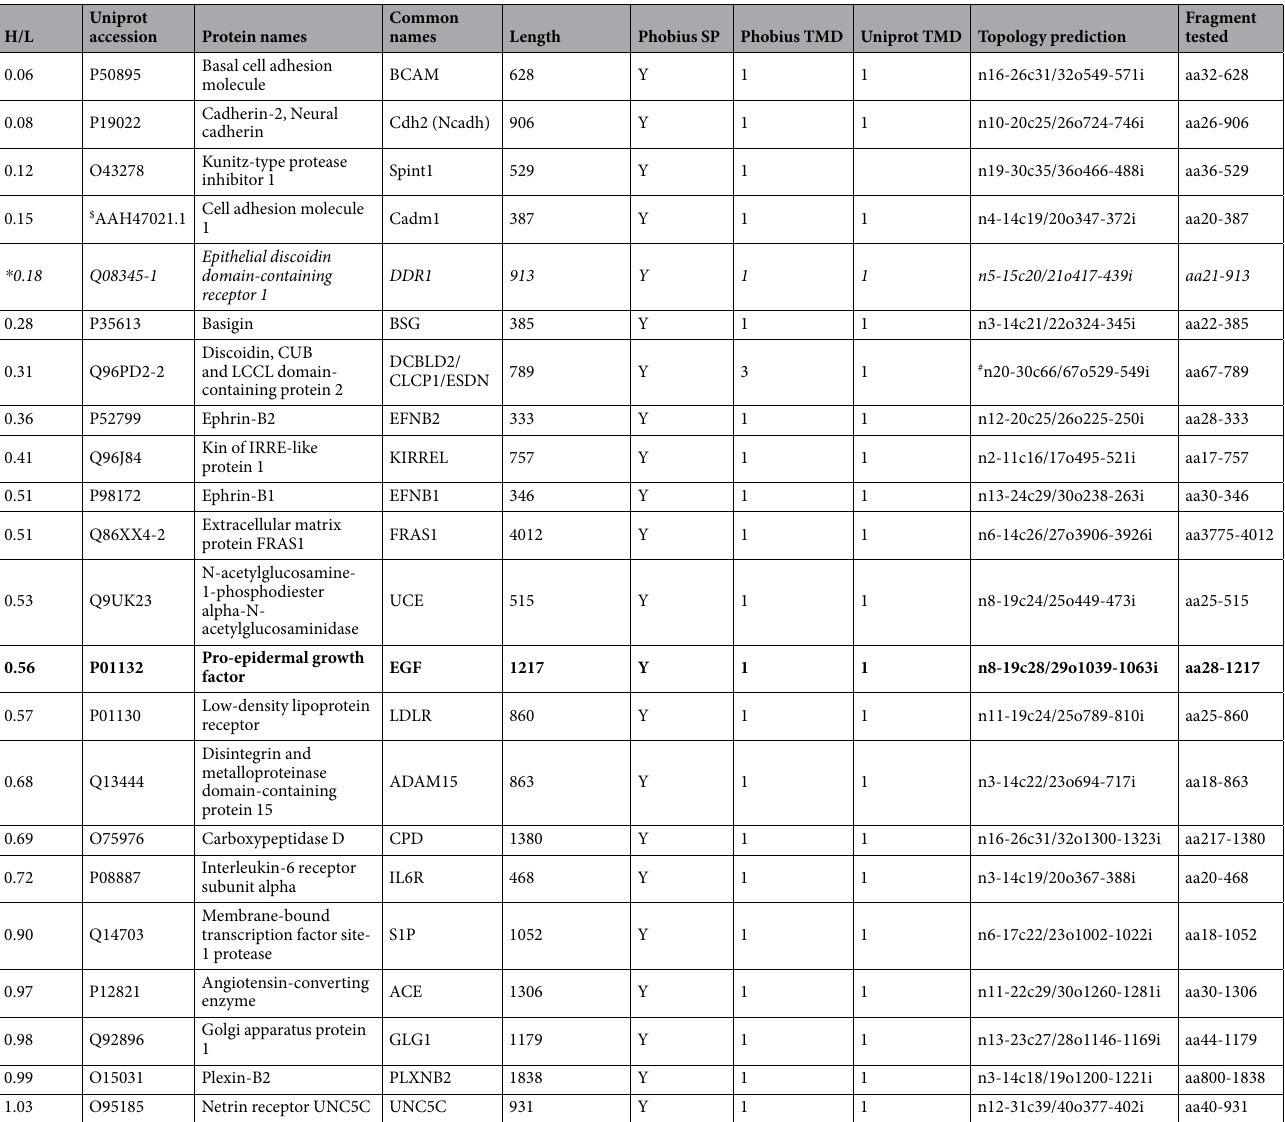
Table 1. Type I membrane proteins identified by SILAC screen for substrates of RHBDL2 that were selected for validation. The cleavage of proteins displayed in Fig. 2 was further validated. The topology prediction is notified as used by the Phobius predictor 15 , that is ‘n’ for the N-terminus, ‘/’ for signal peptide cleavage site, ‘o’ for outer and ‘i’ for inner localisation with respect to the plasma membrane; hyphenated number ranges denote positions of transmembrane helices or signal peptides. $ This is NCBI protein record AAH47021.1, which corresponds to the cDNA IMAGE clone number 5248100 sequence used in this work (which is identical to the NCBI nucleotide record BC047021.1). # For DCBLD2/CLCP1, Phobius predicts 3 TMHs, but the protein is known to have only 1 TMH, and its real topology derived from Uniprot entry Q08345 is displayed. * DDR1 (in italics) was identified only in the initial database searches and not using the current Uniprot/Swissprot human database containing protein isoforms (downloaded 17/03/03), but since it was meanwhile confirmed as a substrate, it has been included also in this final data table. The fragment of each individual protein cloned into N-terminally Strep-His tagged constructs for validation of the SILAC results are denoted by amino acid (aa)